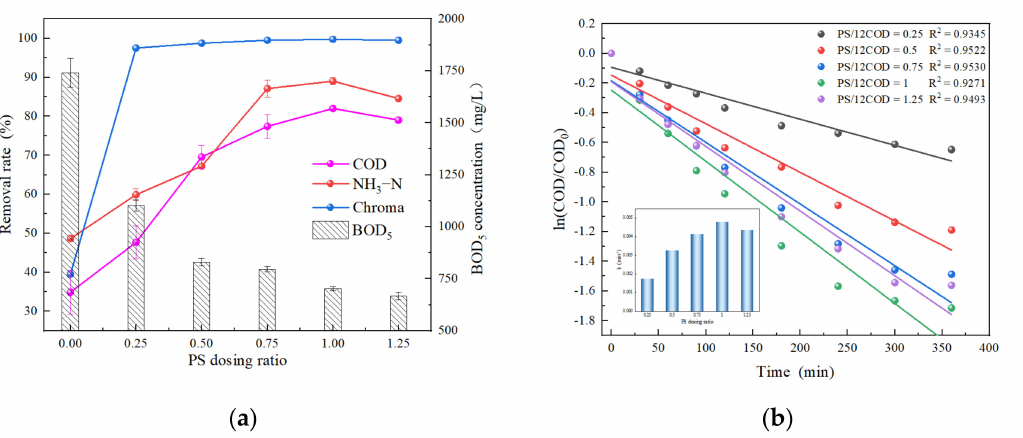
Figure 3. ( a ) Effects of PS dosage on COD, NH 3 -N, chroma removal rate, and BOD 5 content. ( b ) Pseudo-first-order kinetic models of COD degradation at different PS dosage levels. (Initial pH: 3.0; PS/12COD ratio: 1; ZVI dosage: 1.5 g/L; current density: 62.5 mA/cm 2 ; reaction time: 6